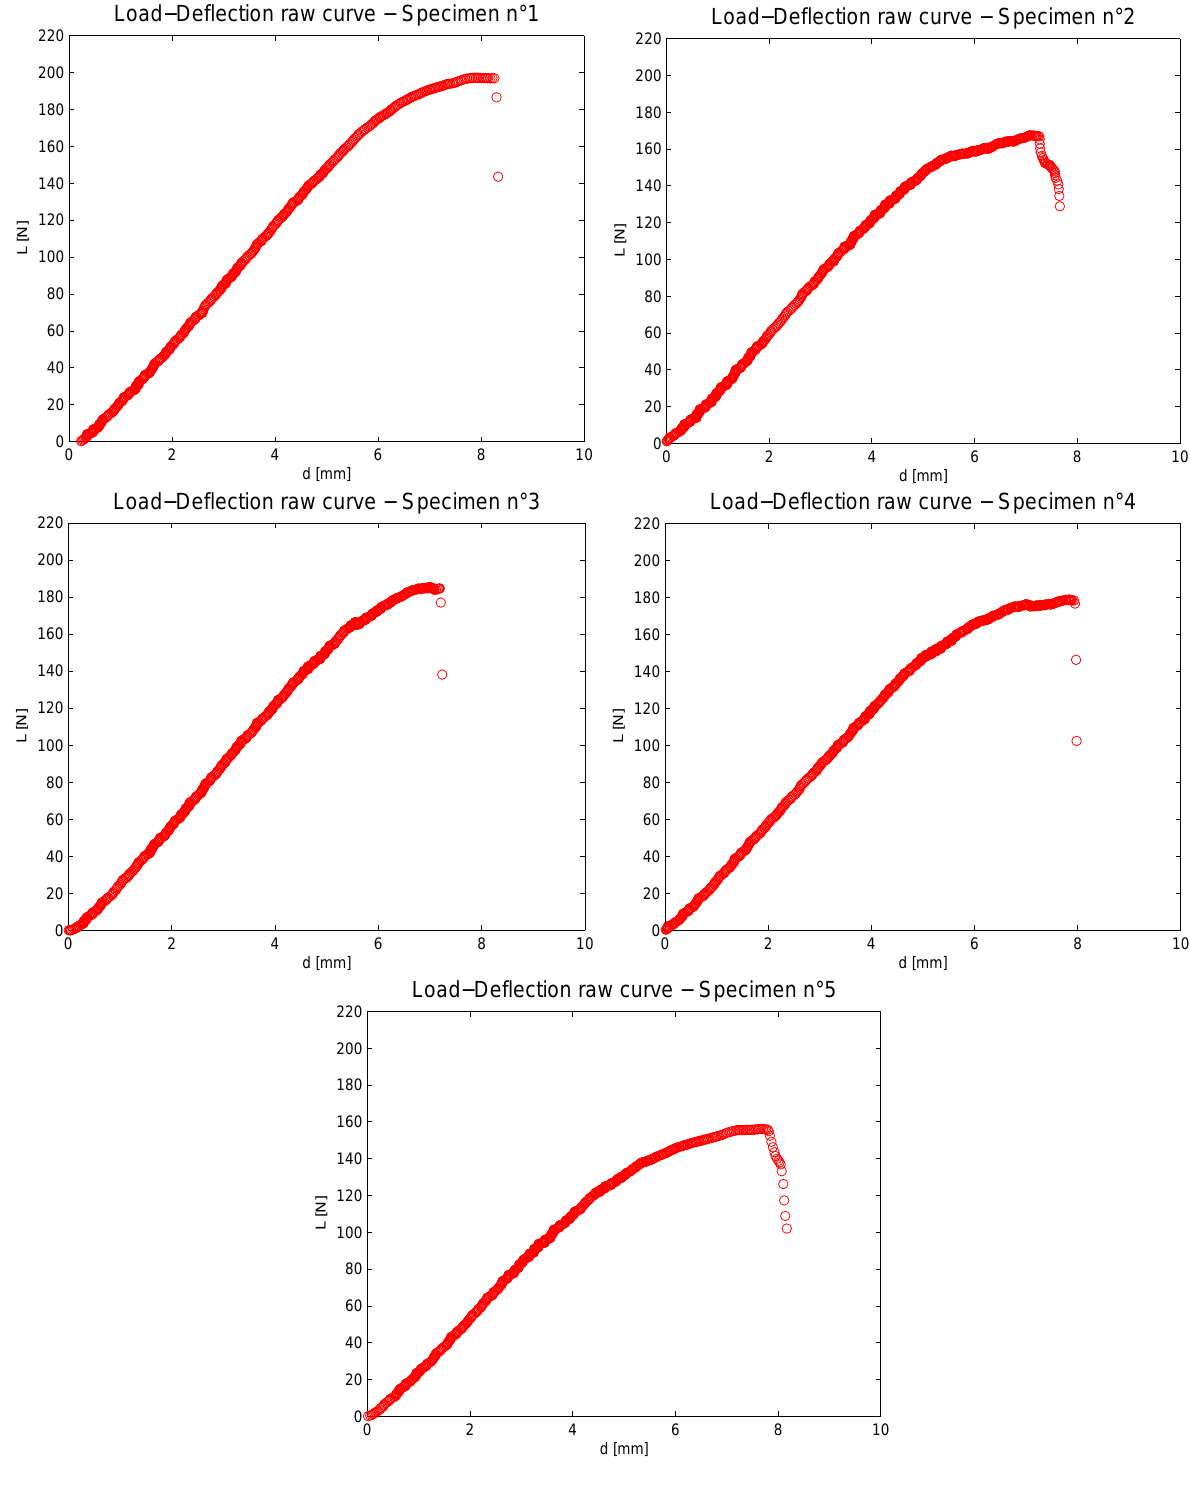
Figure 5: Raw load-deflection curves for specimens